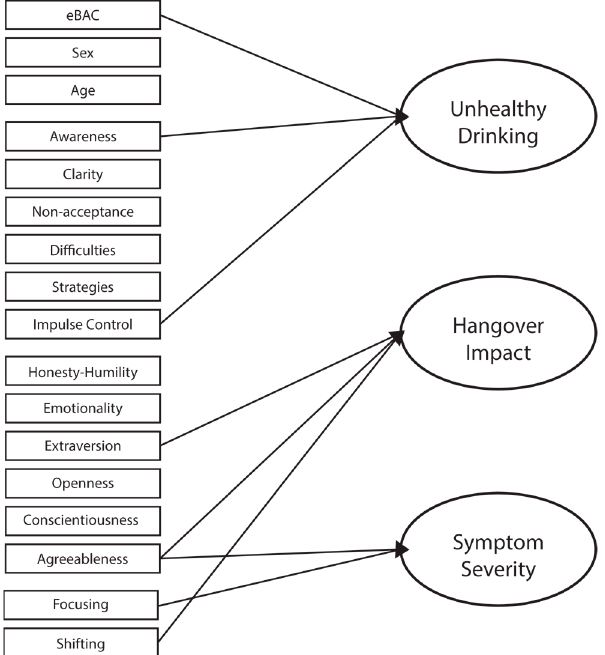
Figure 1. A visual representation of the link between unique predictors and each outcome variable. Arrows between predictors and outcomes are signi fi cant at p < 0.05.